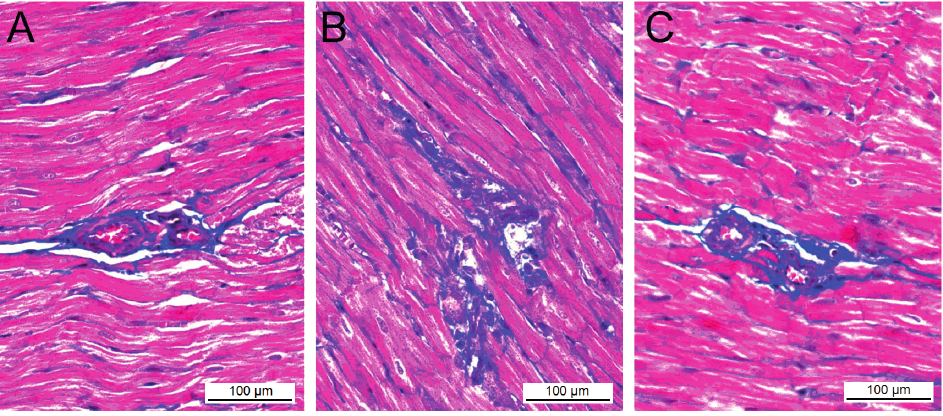
Figure 3. Masson’s trichrome stain of the heart in control group ( A ), AT1-AA group ( B ), and AT1-AA + losartan group ( C ). Where blue = fibrous collagen, and red = cardiomyocytes. ( A ) The comparative fibrosis of control rats ( B ) AT1-AA treated rats showing an increased amount of collagen deposition compared with control rats ( p < 0.05); and ( C ) Less collagen accumulation in the heart of AT1-AA + losartan treated rats, compared with AT1-AA group ( p < 0.05); representative histological